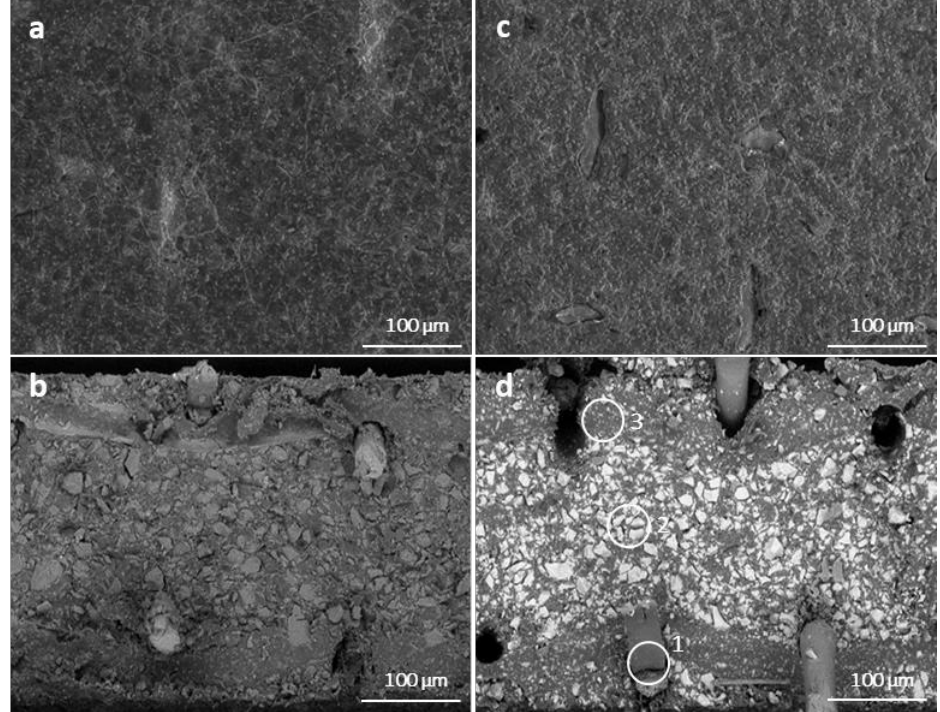
Figure 5. SEM micrographs images: AMH (( a ): surface, ( b ): cross-section); CMH (( c ): surface, ( d ): cross-section). Membrane phases: reinforcing fabric ( 1 ); ion exchange resin ( 2 ); binder polymer ( 3 ).